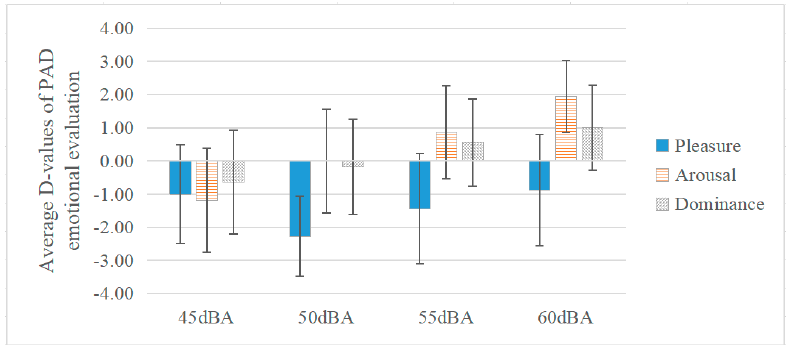
ff ect of SPL on PAD Emotional Evaluation during Communication Figure 4. The Effect of SPL on PAD Emotional Evaluation during Communication (negative). Figure 4. The E